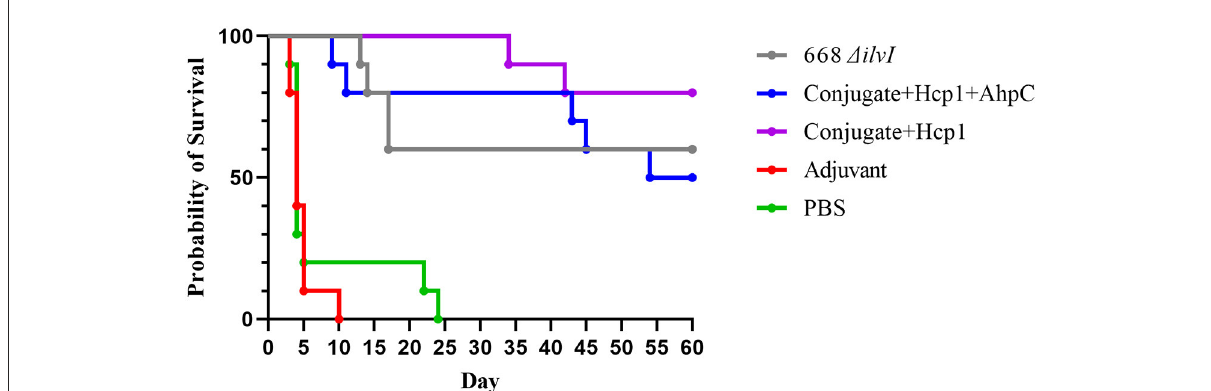
FIGURE2 Survival curves of vaccinated C57BL/6 mice challenged with Bp K96243. Mice ( n = 10/group) were exposed to 3.4 LD 50 (1.35 × 10 3 CFU) by the aerosol route and monitored for 60 days post challenge. The PBS control represented truly naïve mice and the adjuvant control confirmed that protection was not afforded to the mice due to non-specific immune stimulation associated with alhydrogel and CpG injections.